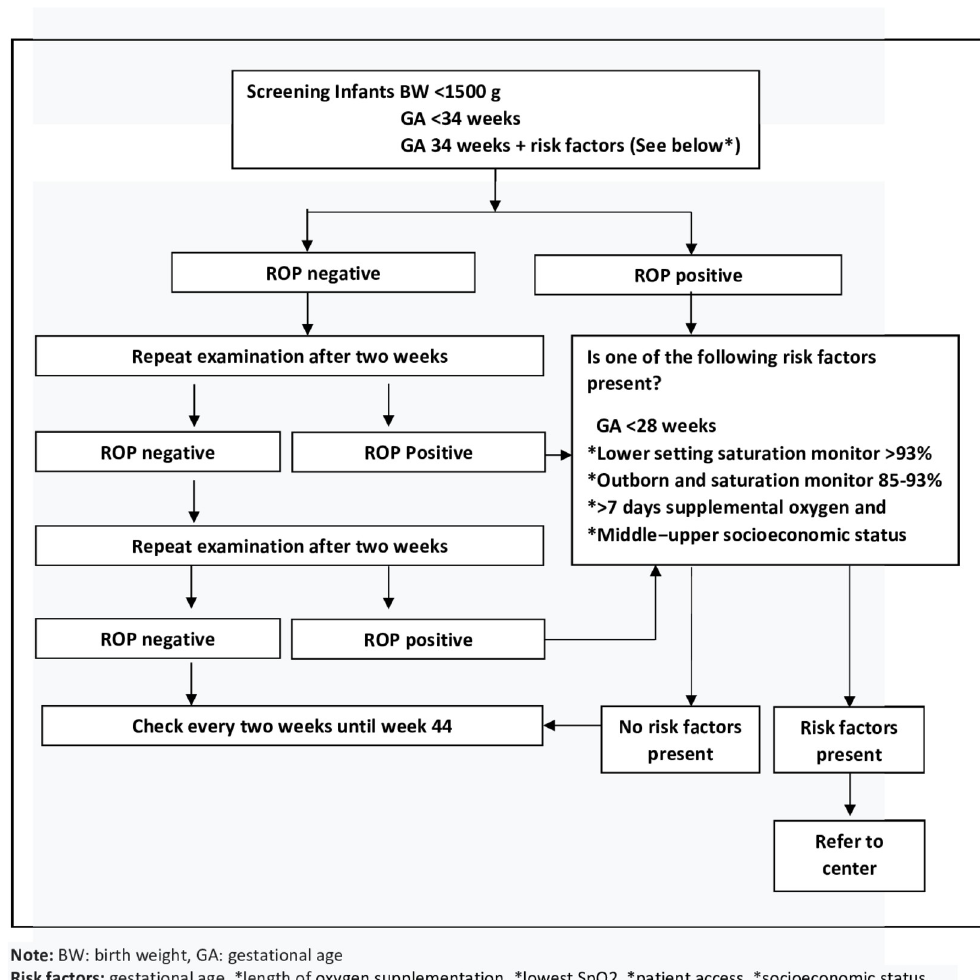
Fig 2. Flow chart for ophthalmologists or assisting physicians to assess the progression of